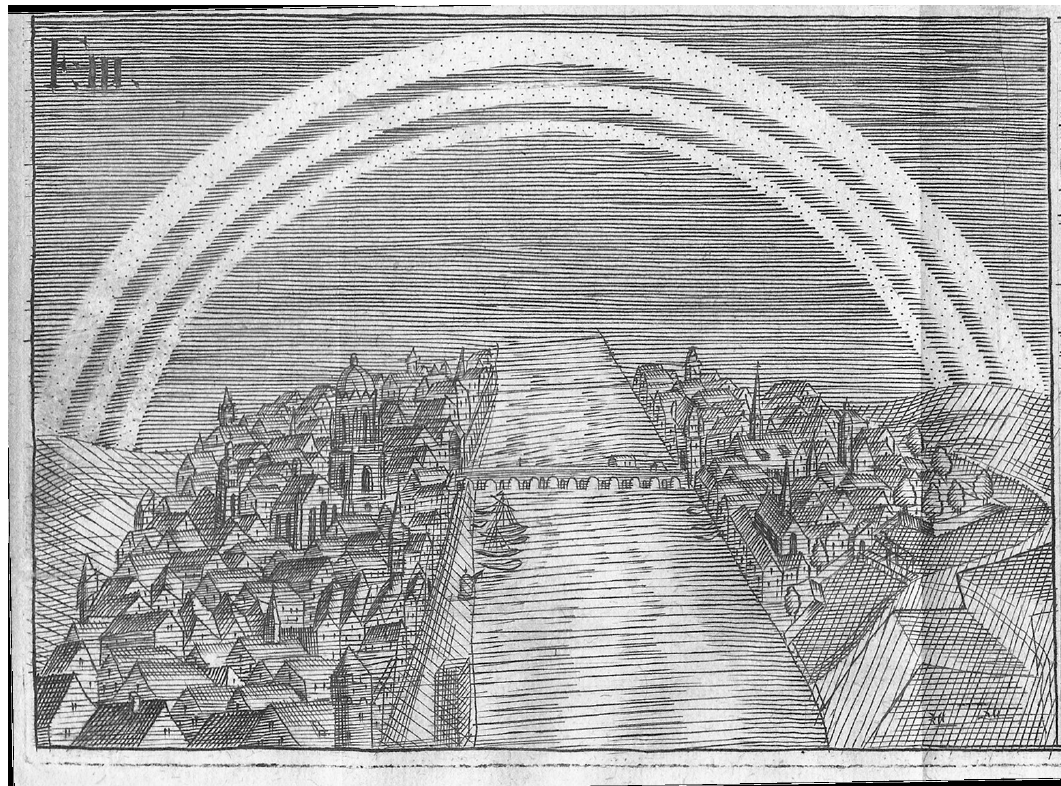
Figure 3. Copper plate of the observation on 1 / 2 March